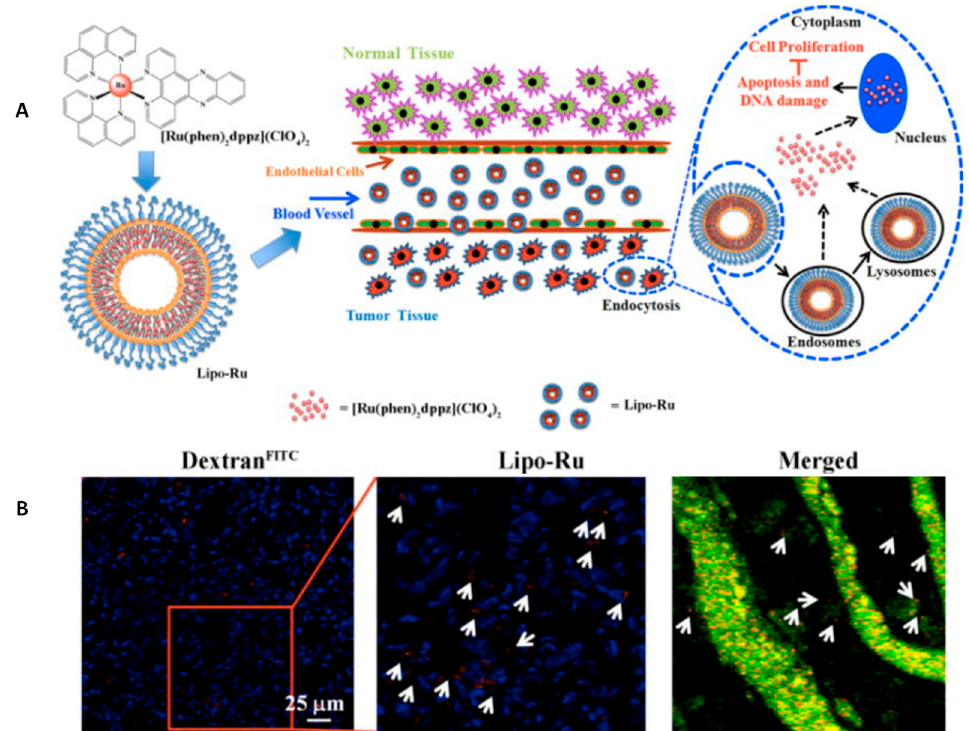
Figure 2. ( A ) Schematic Representation of Lipo-Ru liposomes, and ( B ) confocal microscopy images of tumors 2 h post injection of Lipo-Ru. Lipo-Ru particles are shown in red and highlighted with white arrows. Nuclei are stained in blue with DAPI. Reprinted with permission from reference [51].